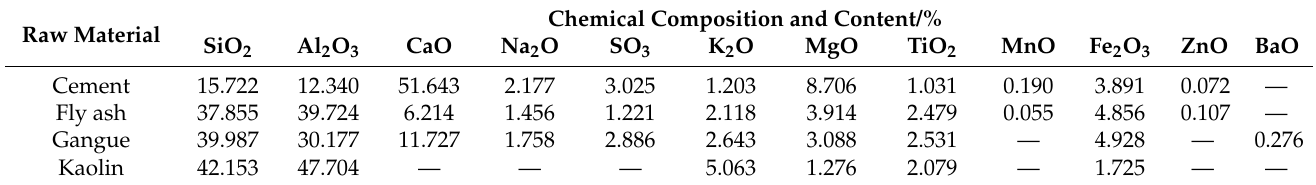
Table 1. Main components and